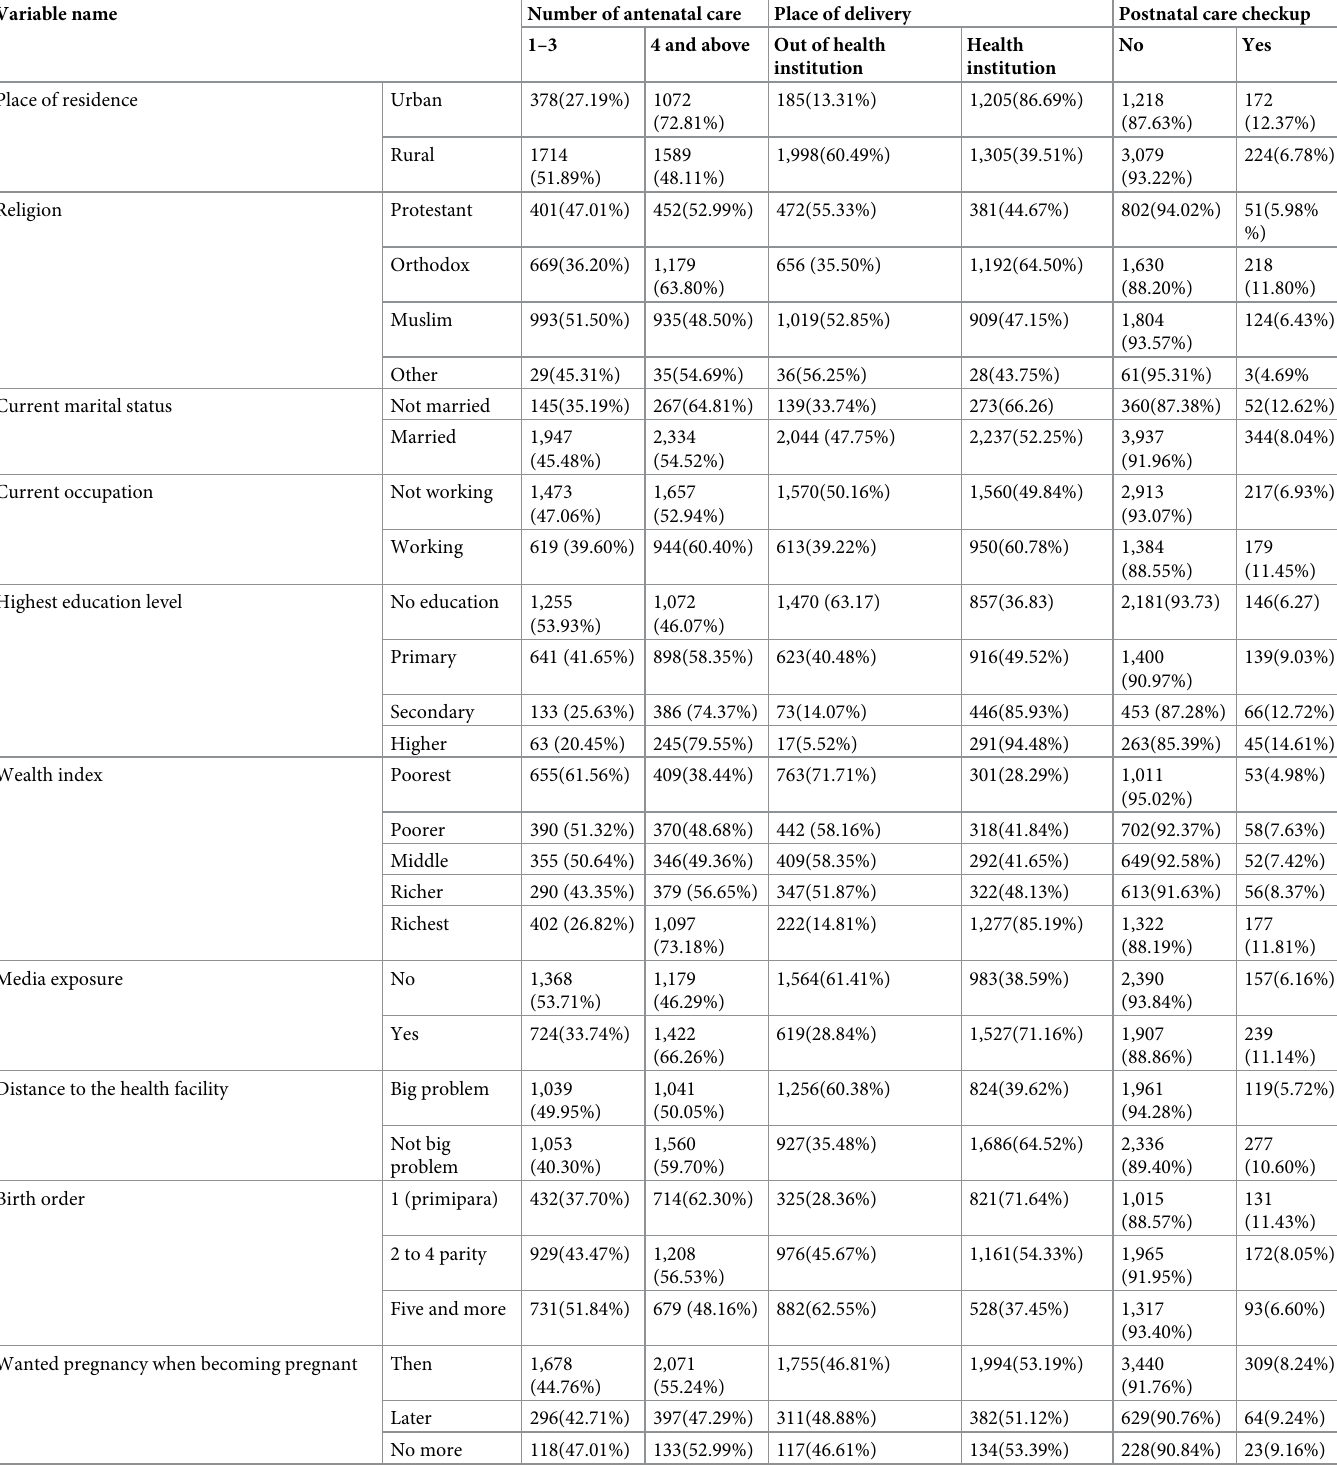
Table 1. Background characteristics of reproductive-age women who give birth within five years before the survey after antenatal care booking in Ethiopia, EDHS 2016